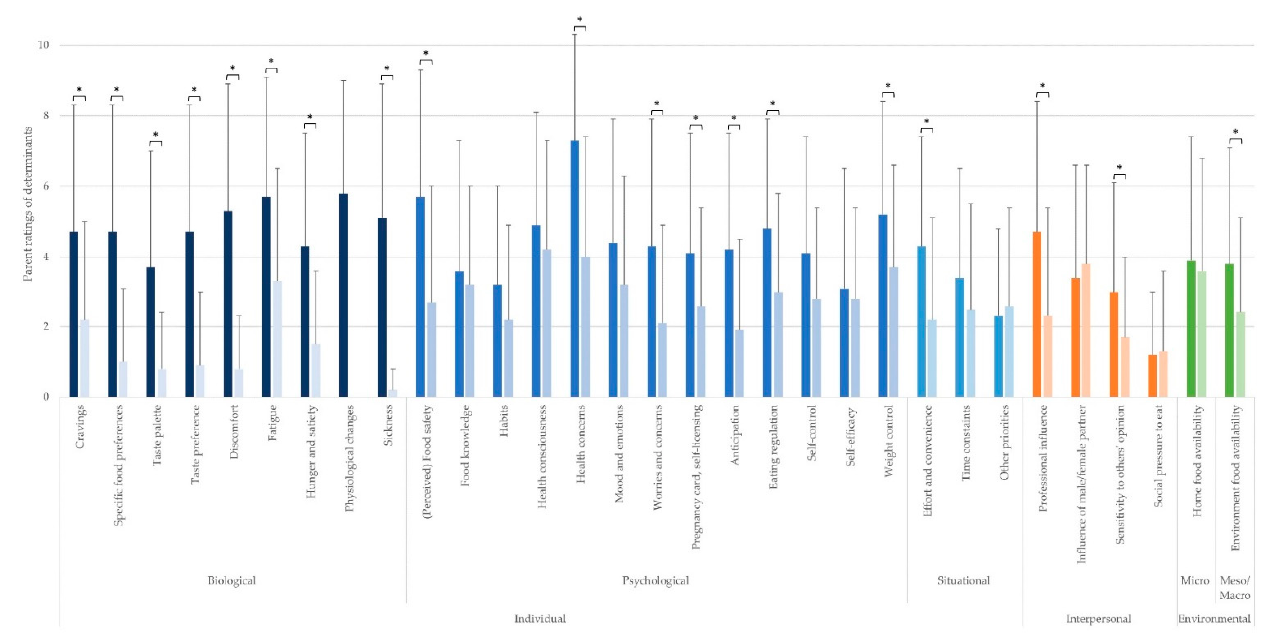
Figure 2. Parents’ rating of determinants of changes in eating behavior (mean ± SD; rated on a scale from 0 to 10) during pregnancy. * Statistically significant sex differences. The colors of the bars depict the (sub)level of the determinants: blue for the individual level (darkest blue: biological sublevel, medium blue: psychological sublevel, lightest blue: situational sublevel), orange for the interpersonal level, and green for the environmental level. The left bar (i.e., darker color) of each determinant depicts the score for pregnant women, and the right bar (i.e., lighter color) of each determinant depicts the score for (expecting) fathers.